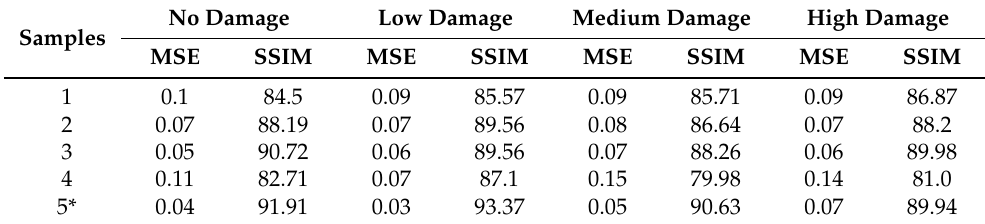
Table 21. Hyper reconstruction of images from each class. Samples